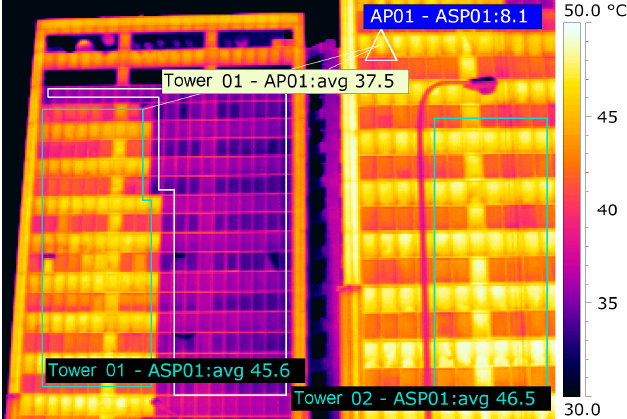
Figure 10. Thermal image of the facade of two buildings [5].